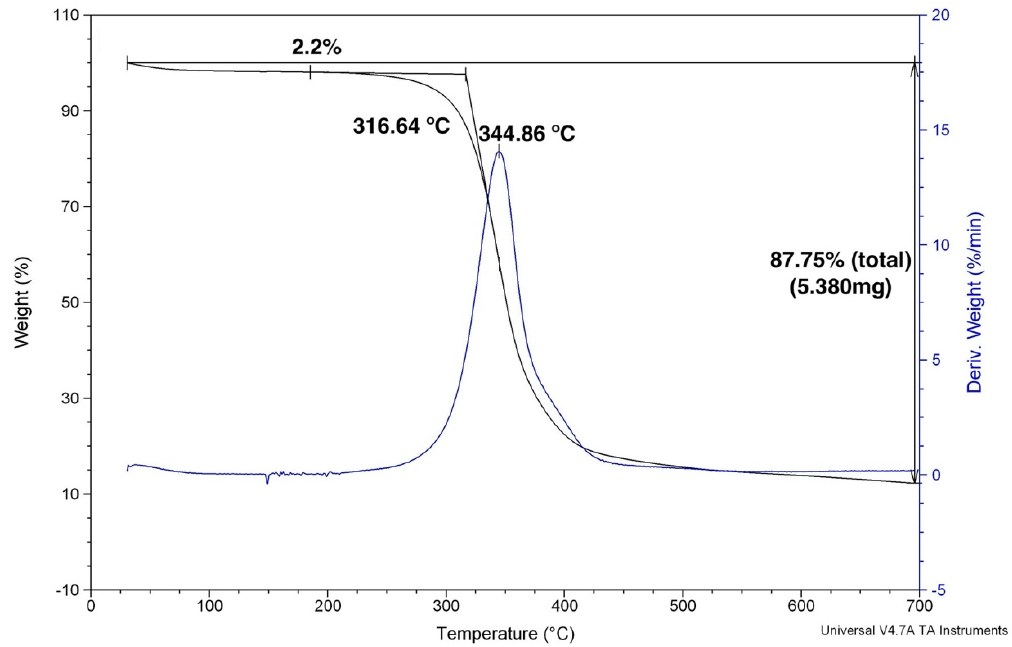
Figure 6. TGA curves for the graphene oxide (GO)-free epoxy composite reinforced with 30 vol% of ramie fabric. Polymers 2020 , 12 , x